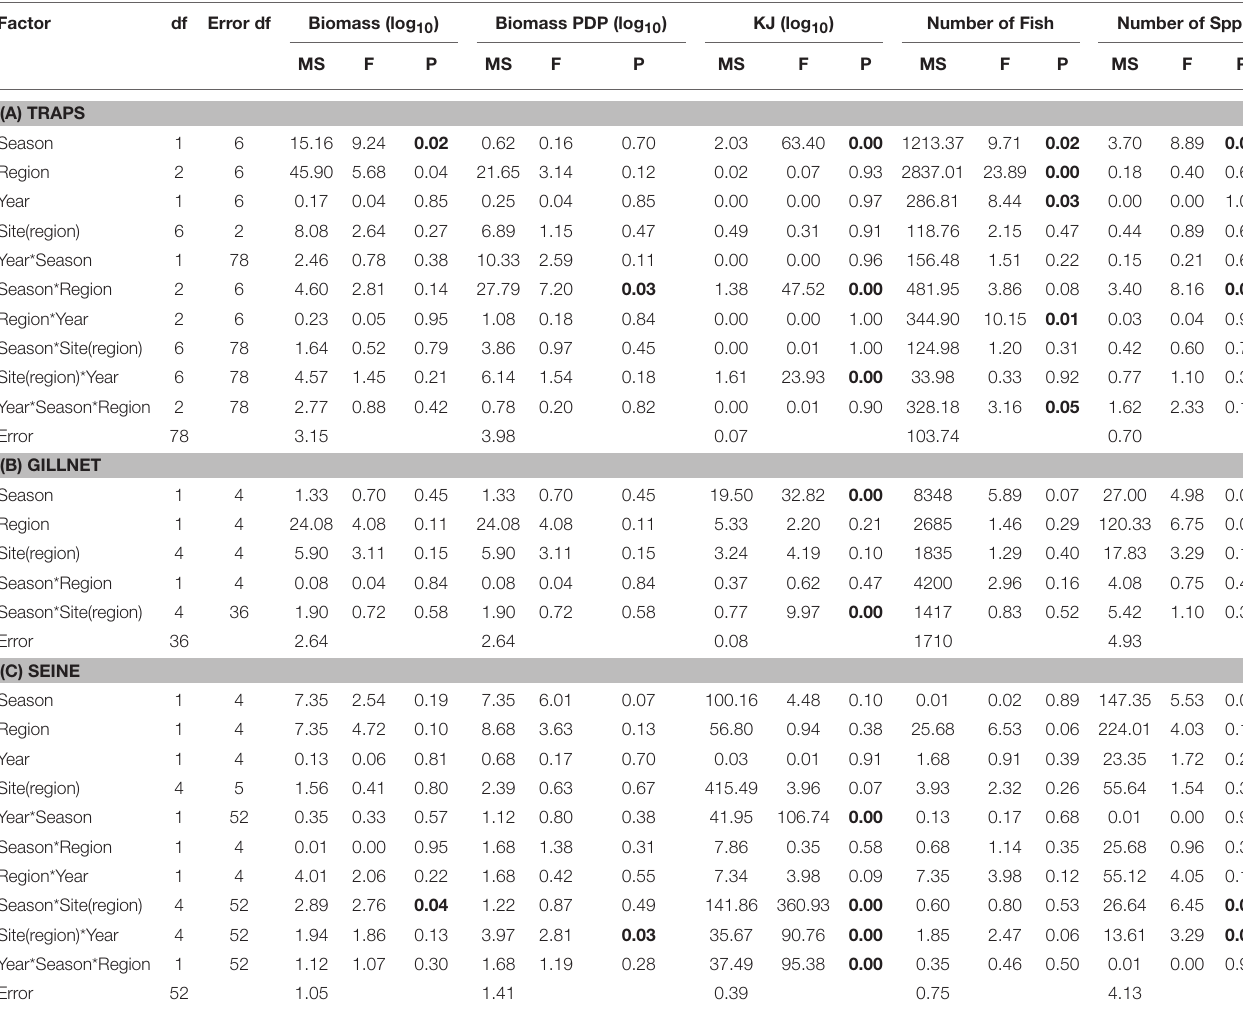
TABLE 6 | Summary of the results of nested ANOVAs to test for seasonal differences in the biomass, PDP biomass, KJ, number of fish, and number of species caught in (A) traps, (B) gillnets, and (C) seine nets between seasons, years and among regions and sites within region.